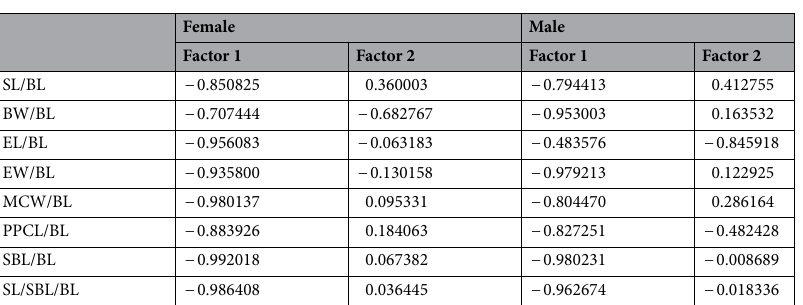
Table 1. Factor loadings of the PCA using morphometric data obtained from females and males of Carcinonemertes camanchaco sp. nov., based on a correlation matrix. Measurements: BL = total body length, BW = body width, EL = eye length, EW = eye width, MCW = middle chamber width, SL = stylet length, SBL = stylet basis length, PPCL = posterior proboscis chamber